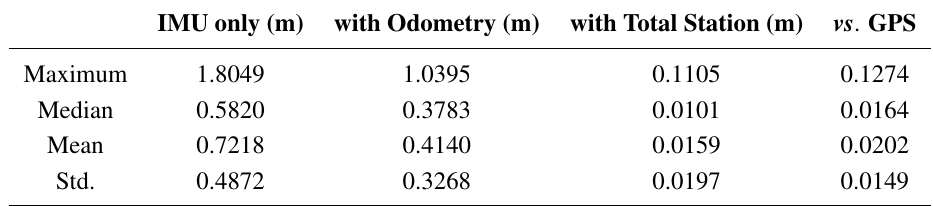
Table 2. Error analysis of control points with quadratic deviation; Case 1: IMU; Case 2: IMU and odometry; Case 3: IMU, odometry and total